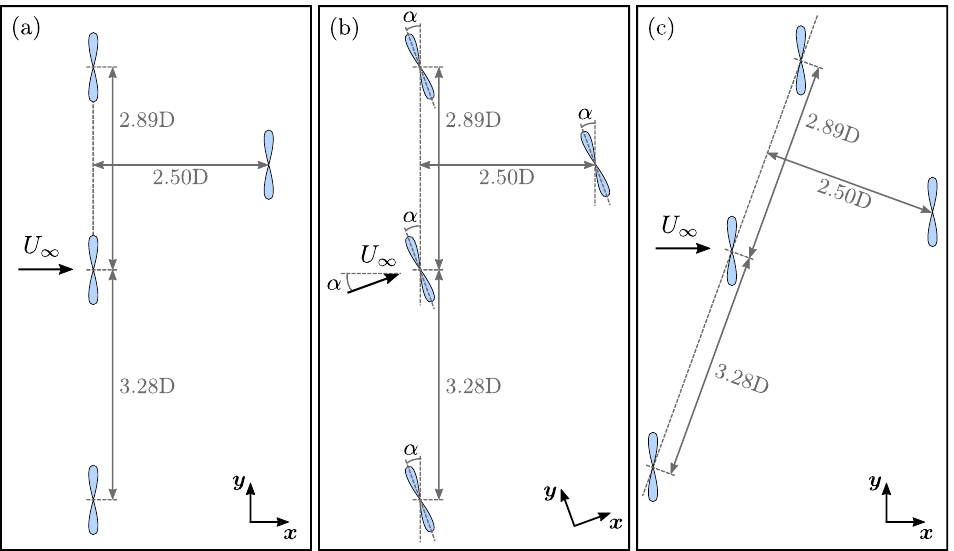
Figure 10. Four tidal turbine array configurations: ( a ) initial configuration (straight flow), ( b ) config- uration with a yawed flow, ( c ) configuration with a yawed flow used for the